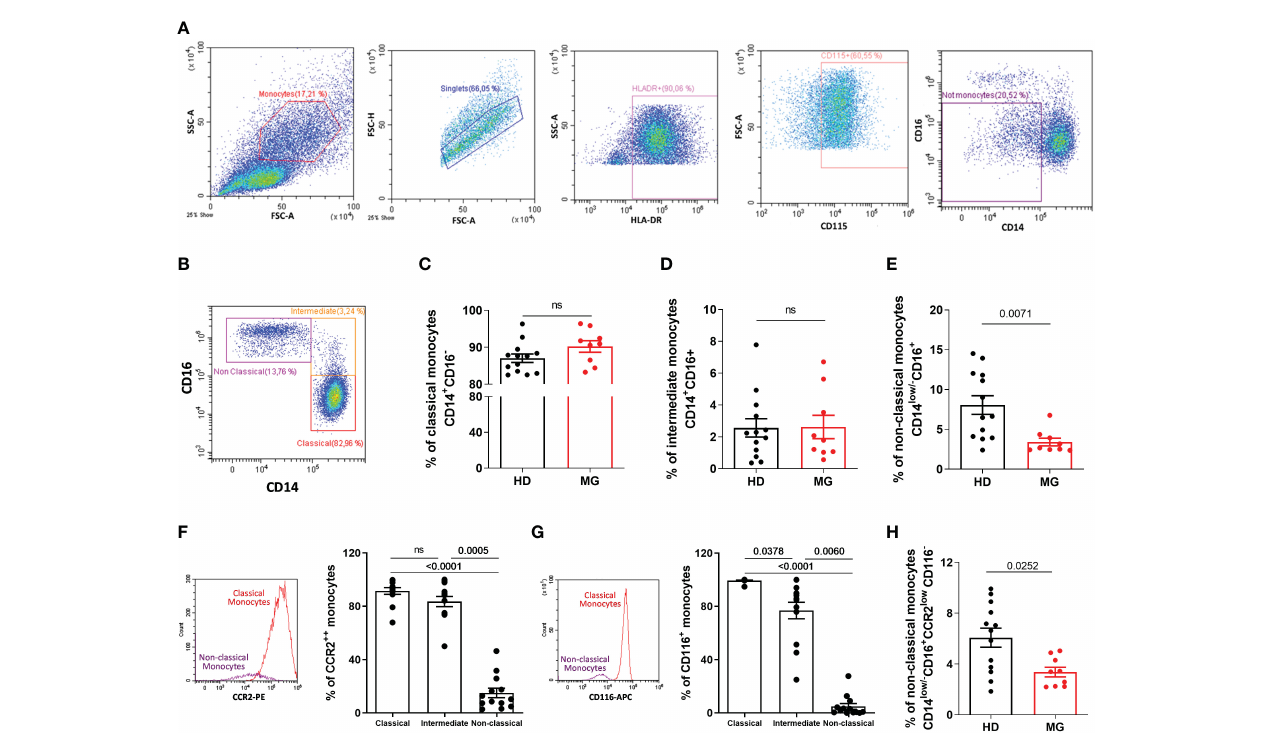
FIGURE 6 Analysis of monocytes by fl ow cytometry. Analysis by fl ow cytometry (A – B) of the percentages of classical (C) , CD14+CD16-), intermediate (D) , CD14 +CD16+), and non-classical ( E) , CD14low/-CD16+) monocytes in PBMCs from healthy individuals (HD) or in AChR MG patients (MG). Analysis of the percentage of CCR2 (F) and CD116 (G) expression by monocyte subpopulations in healthy donors. Percentage of newly de fi ned non-classical monocytes (H) . p values were determined by the Mann-Whitney test (C – E, H) or the Kruskal-Wallis test with Dunn ’ s multiple comparisons test for multiple comparisons (F, G)